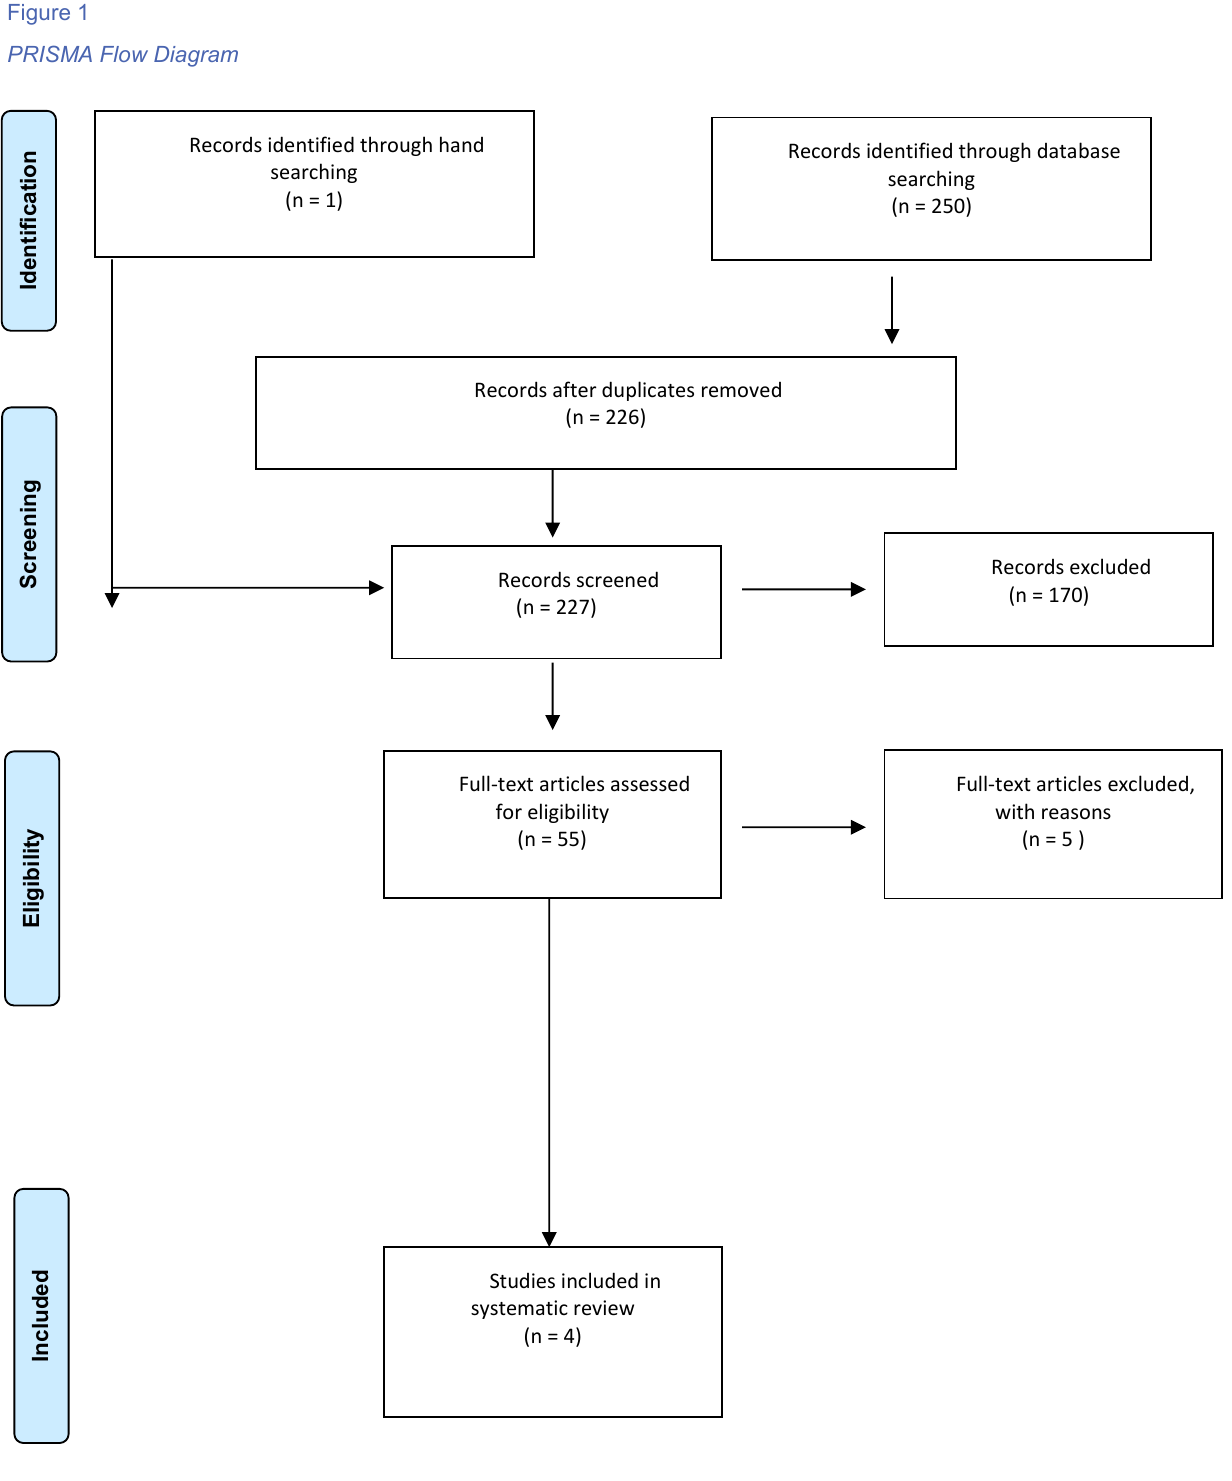
Note . PRISMA flow diagram showing search and selection process that yielded the final four